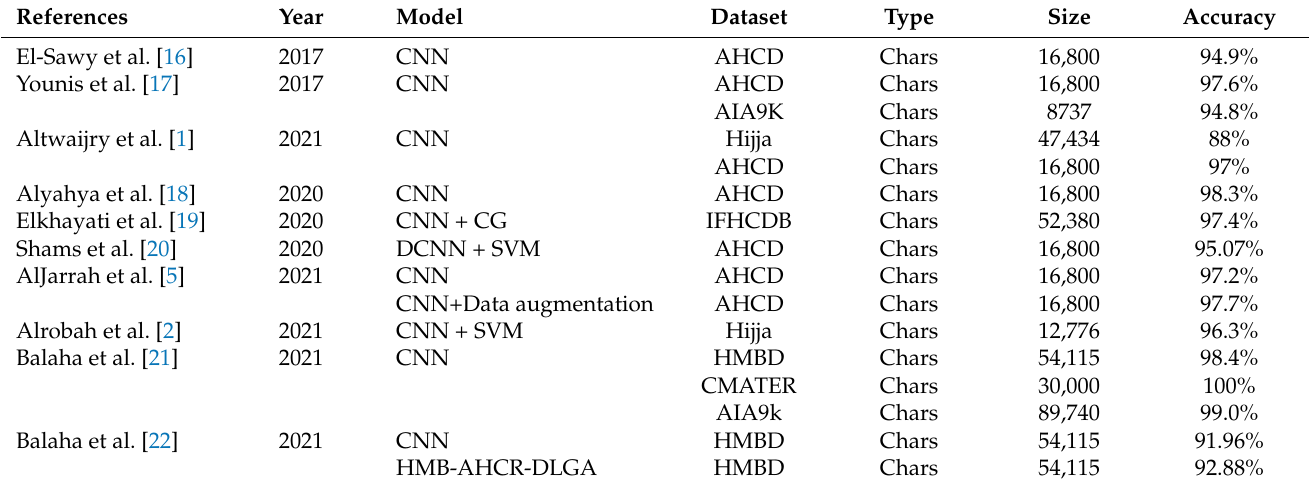
Table 2. A summary of deep learning-based handwritten character recognition